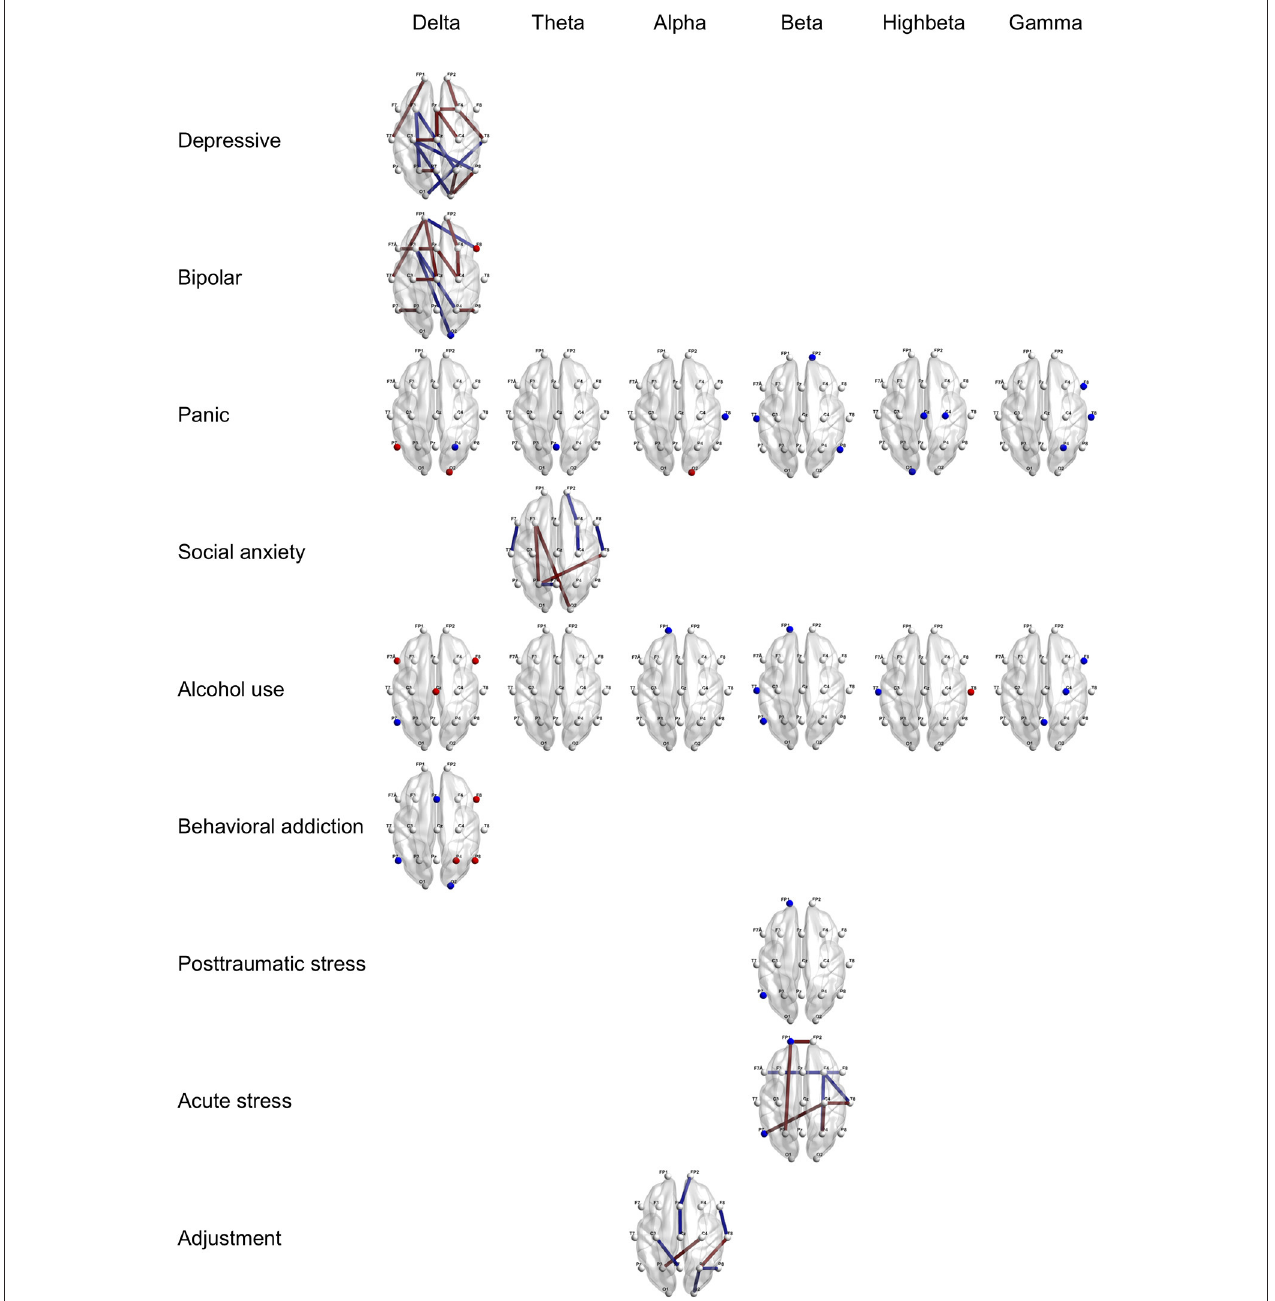
FIGURE 3 | Region-wise predictions for specific psychiatric disorders. Dots and lines represent region-wise survived predictors in the best EN model, which emerged significant above 7 times during 10 times of cross-validation. Dots mean channel-level PSD (absolute power) as QEEG parameter and lines mean channel-level FC (coherence) as QEEG parameter. Features colored in red represent higher probabilities for the psychiatric disorder when more increase. Features colored in blue represent higher probabilities for the psychiatric disorder when more decrease. Age, sex, the year of education, and the IQ score were computed in the models. EN, Elastic Net; PSD, Power Spectrum Density; FC, Functional Connectivity; QEEG, Quantitative Electroencephalography; and IQ, Intelligence Quotient.